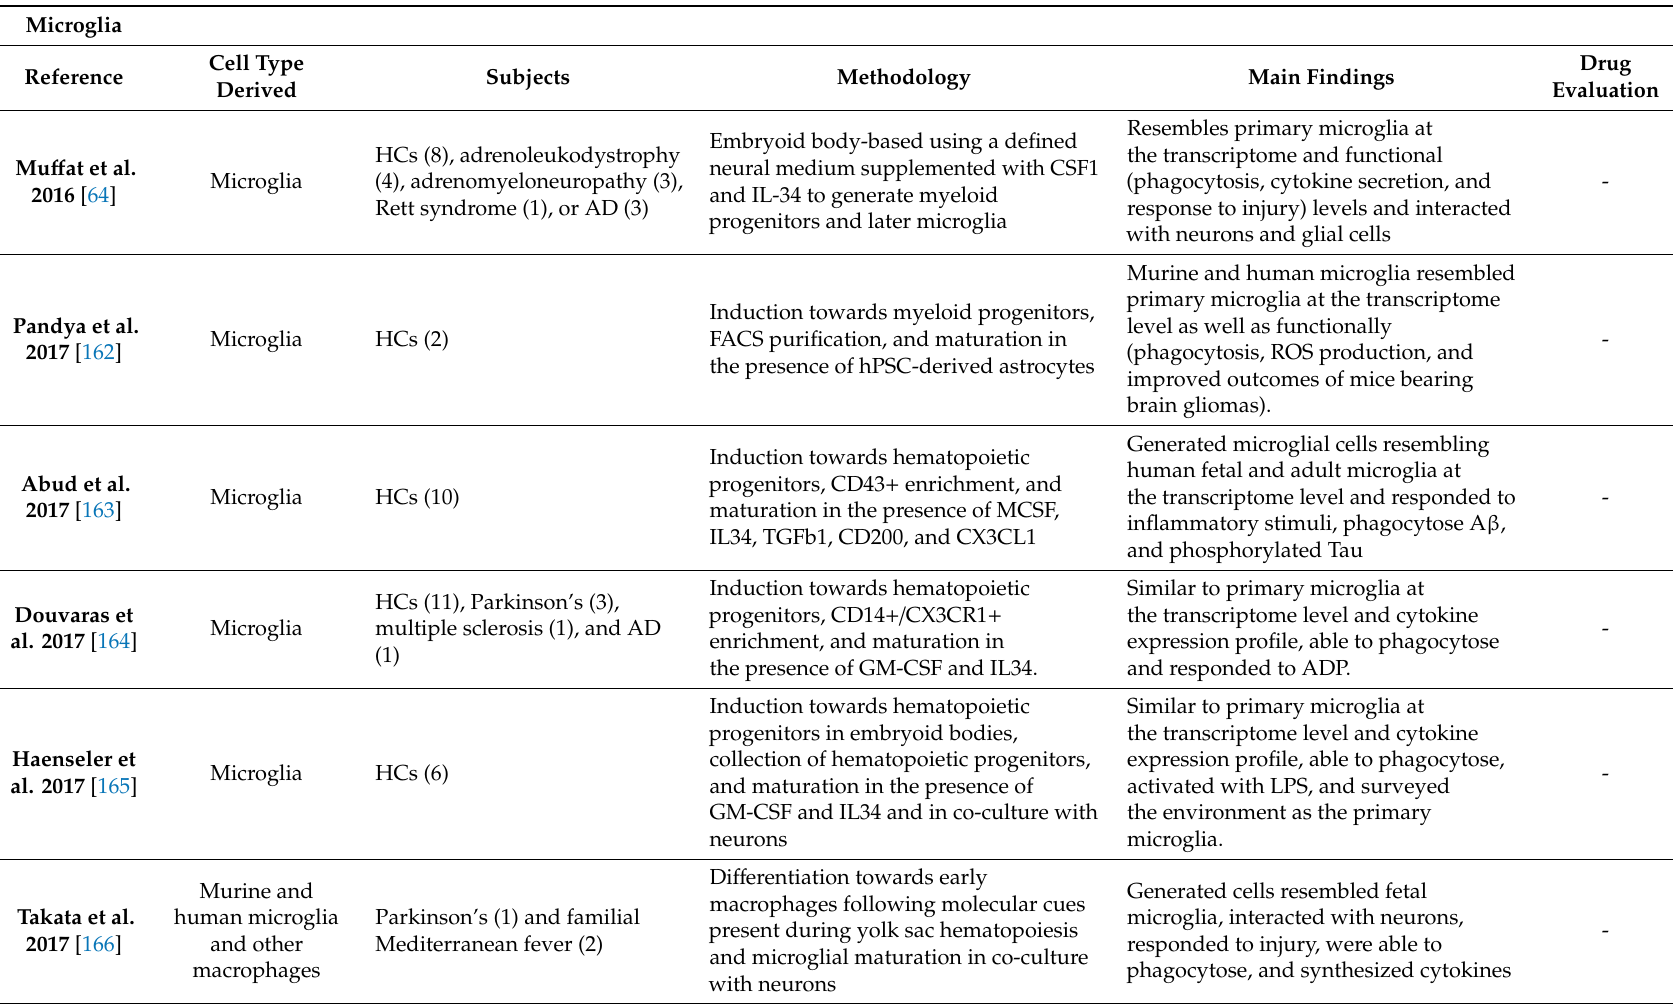
Table 3. Summary of the findings of the main studies describing the generation of hPSC-derived microglia from patients with Alzheimer’s